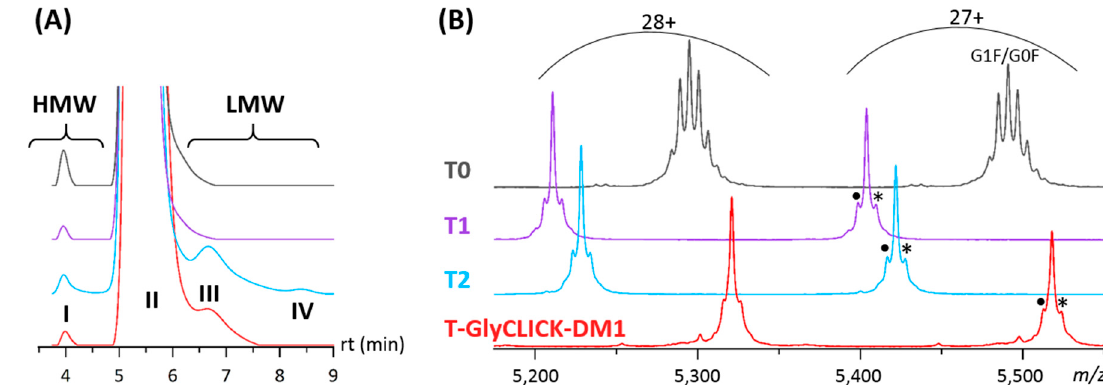
Figure 3. Online SEC-nMS analysis of initial (T0), intermediate (T1 and T2) and end (T-GlyCLICK-DM1) conjugation products. ( A ) Zoom on SEC-UV chromatograms at 280 nm; I = HMW dimers, II = main product, III = Fc-Fab fragments and IV = LC, Fd and Fab fragments. ( B ) Zoom on SEC-nMS spectra obtained for the different main products; • = a-fucosylation (–146 Da), ✱ = glycation (+162 Da). Table 1. Masses of species detected with SEC-nMS. Relative quantification of the different species was assessed based on SEC-UV signals. * ND = mass not determined because of very low intensities on the nMS spectrum. T0 T1